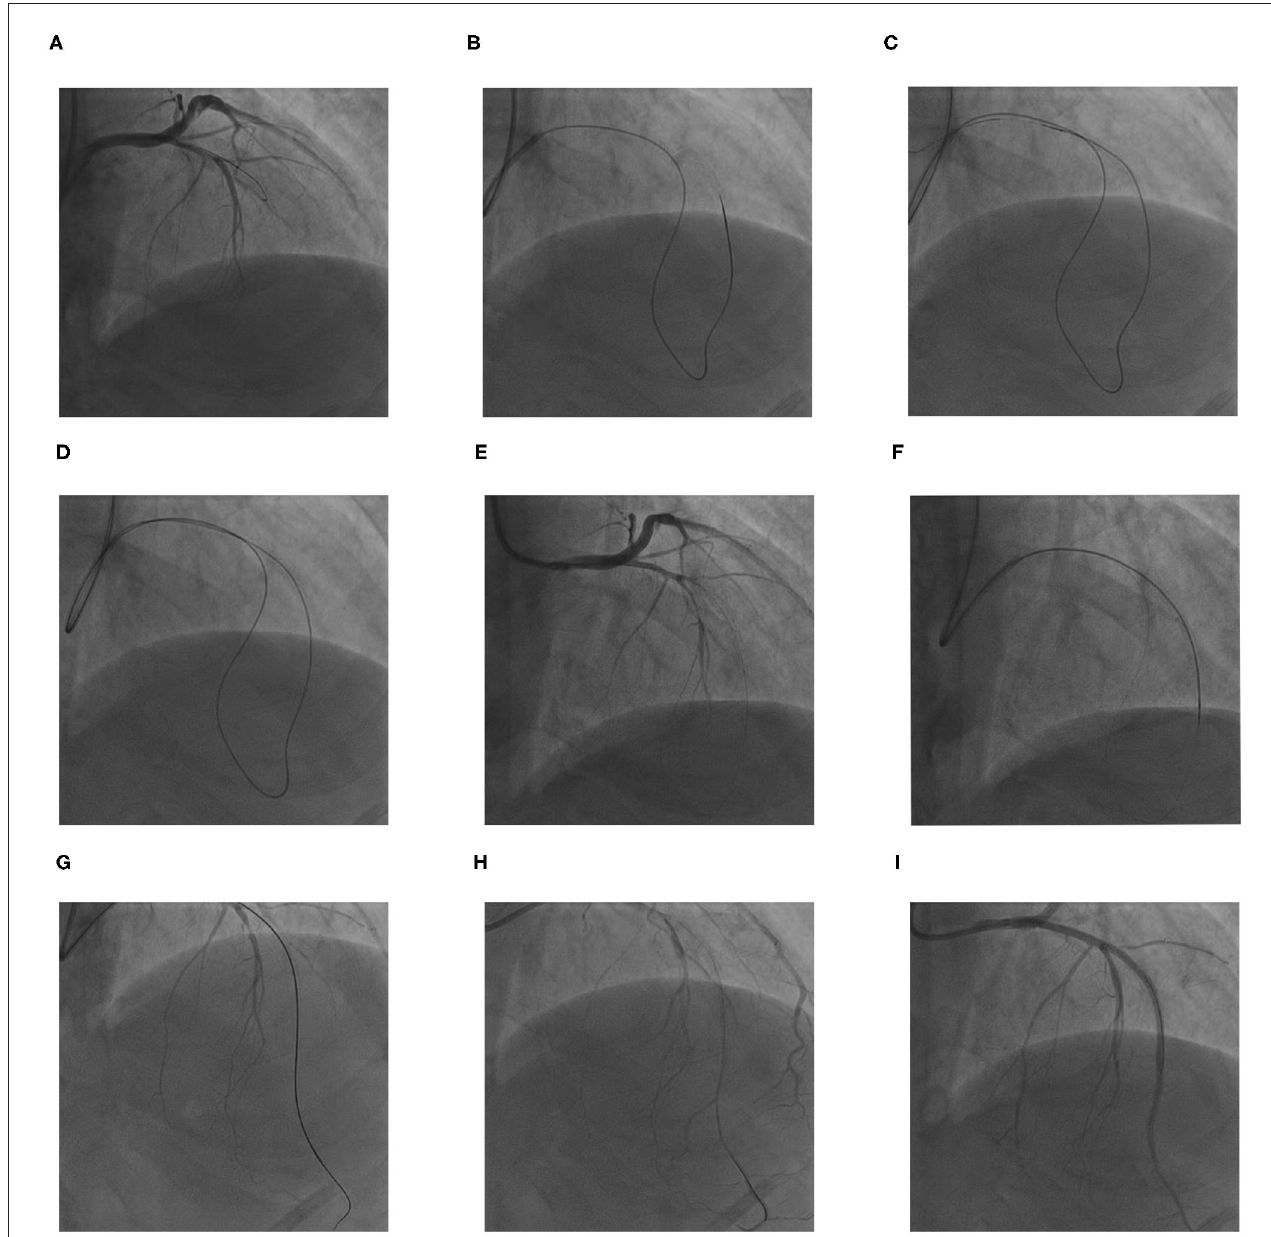
FIGURE 2 | The procedures for retrograde percutaneous coronary intervention (PCI) of LAD chronic total occlusion (CTO). (A) The antegrade wire could not cross the CTO lesion. (B) The retrograde soft wire was advanced through the septal collateral with the microcatheter reaching the distal CTO lesion. (C,D) The retrograde soft wire was exchanged for a stiff wire via microcatheter, which crossed the CTO segment into proximal LAD true lumen, and threaded into the antegrade catheter with microcatheter retrogradely. (E) A 300-cm RG3 wire was externalized via the microcatheter. (F) The microcatheter was inserted into the proximal LAD through the septal collateral antegradely; the RG3 wire was removed. (G,H) The microcatheter was introduced to the distal LAD; the antegrade wire was advanced through the lesion. When the wire was confirmed in true lumen by angiogram, the microcatheter was removed. (I) Three drug-eluting stents were deployed at mid LAD